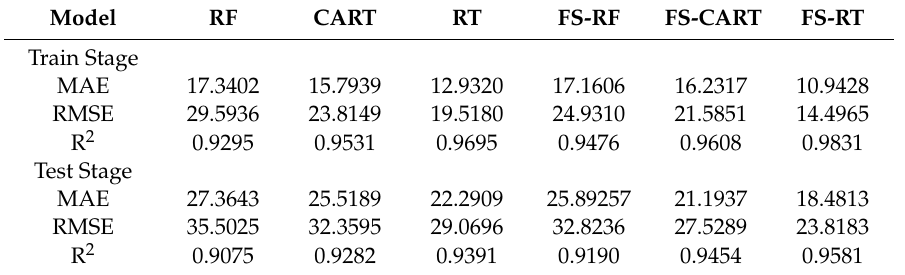
Table 2. The results of various models in predicting the punching shear capacity of SFRC flat